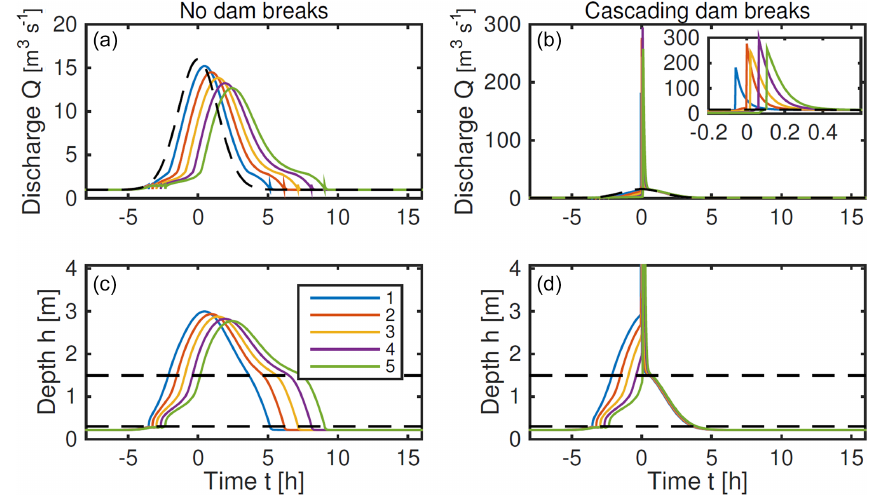
Figure 10. Maximum discharge at downstream node for an ensemble of runs (indexed on abscissa) on the two-dimensional network in Fig. 9, forced by uniform inflow to each of the eight branch nodes q(t) = q 0 + q max exp ( − t 2 /σ 2 ) , with q 0 = 0 . 125m 3 s − 1 , q max = 1 . 5m 3 s − 1 and σ = 2h. Each dam is assigned a failure depth h c drawn from a normal distribution with a mean of 3.5m and standard deviation of 0.5m. In i the first case, dams are placed on the four trunk segments (nodes 1–4), while in the second case they are placed on the upstream side branches (nodes 5, 6, 9, 10). The size and colour of the dots indicate the number of dams that failed in each realisation, and the dashed line shows the peak discharge in the case that no dams are installed. Parameter values are as in Fig. 7.